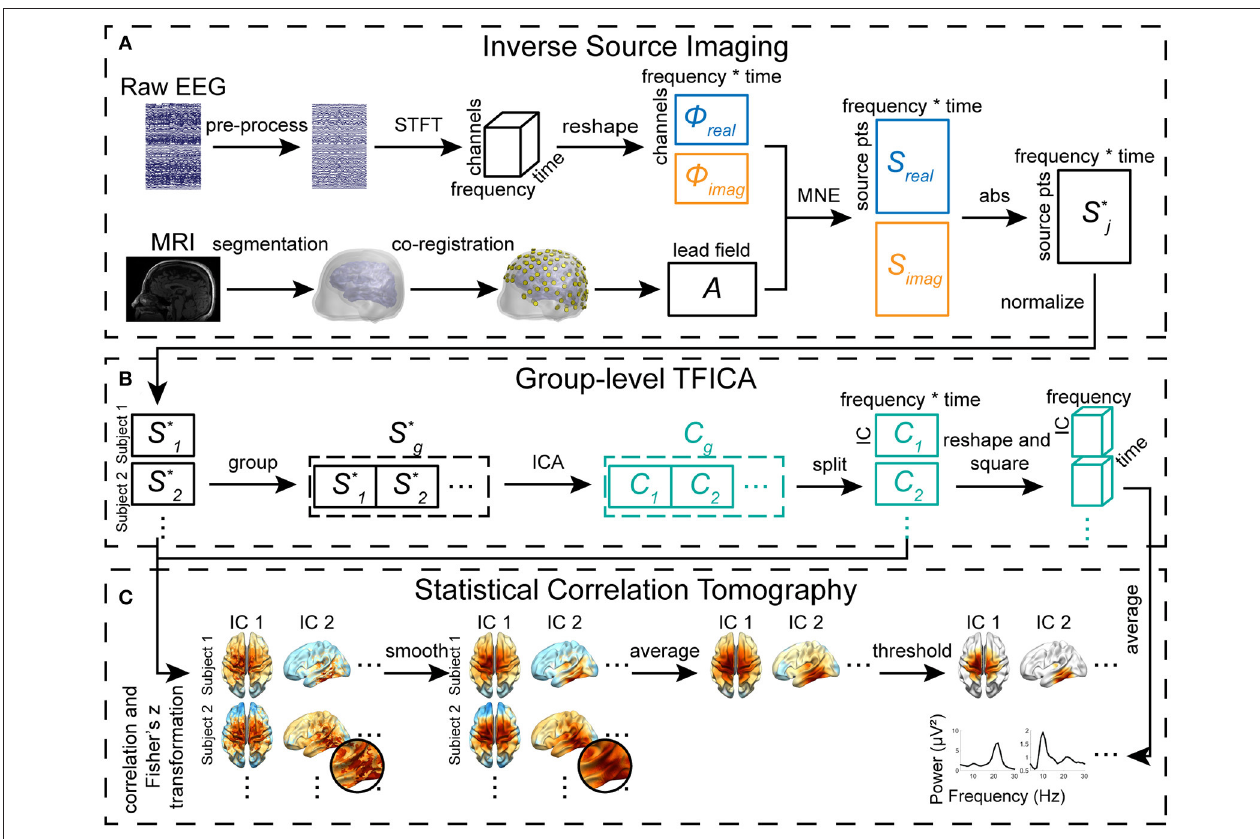
FIGURE 1 | Diagram of TFICA-SCT. (A) Inverse source imaging, including EEG preprocessing, STFT, volume conduction modeling, BEM forward calculation of lead field, and MNE inverse solution. (B) Group-level TFICA on the cortical source domain. (C) Statistical correlation tomography derived by correlational analysis of time courses between ICs and